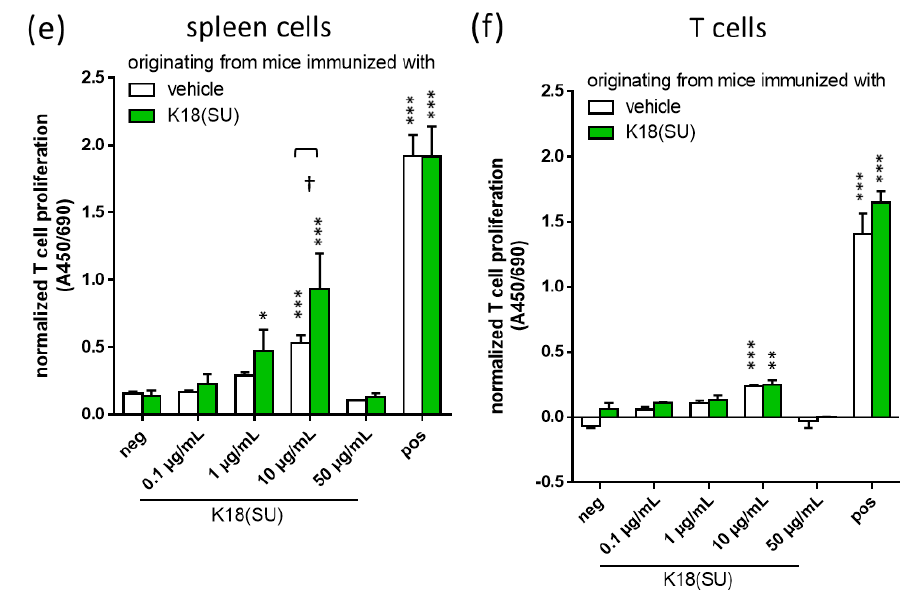
Figure 3. Antibody and T-cell response to recombinant HERV-K18(SU). ( a , b ) Six week old female Balb/c mice received two subcutaneous immunizations (indicated by arrows) with 50 µg HERV-K18(SU) ( n = 3) or a vehicle ( n = 2) in IFA with a four-week interval. Plasma IgG titers were analyzed at three time points using HERV-K18 Env-specific ELISA. As ELISA plates could not be coated with insoluble recombinant HERV-K18(SU), cell extracts that did (target) or did not (background) contain HERV-K18 Env were used instead. Graphs in ( a , b ) show original absorbance data and the background subtracted values, respectively. Representative results of one of two independent experiments are shown as the mean ± SEM. Statistics: unpaired t -test (K18(SU) versus vehicle). ( c , d ) Balb/c mice ( n = 5) were immunized intraperitoneally with 10 µg HERV-K18(SU) daily for 3 × 5 days. Plasma IgG titers were analyzed using HERV-K18 Env-specific ELISA as described above. Graphs in ( c ) and ( d ) show original absorbance data and the background subtracted values, respectively. Statistics: unpaired t -test (K18(SU) versus vehicle). ( e , f ) Isolated splenocytes ( e ) or MACS-sorted T cells ( f ) from immunized mice were isolated and stimulated with different amounts of HERV-K18(SU), buffer (neg), or dynabeads (pos) for 48 h. Thereafter, T-cell proliferation was determined using BrdU ELISA. Bars show means ± SEM (each n = 3). Statistics: one-way ANOVA with Dunnett’s post hoc test (neg versus all other groups), * p < 0.05, ** p < 0.01, *** p < 0.001. Unpaired t -test, † <